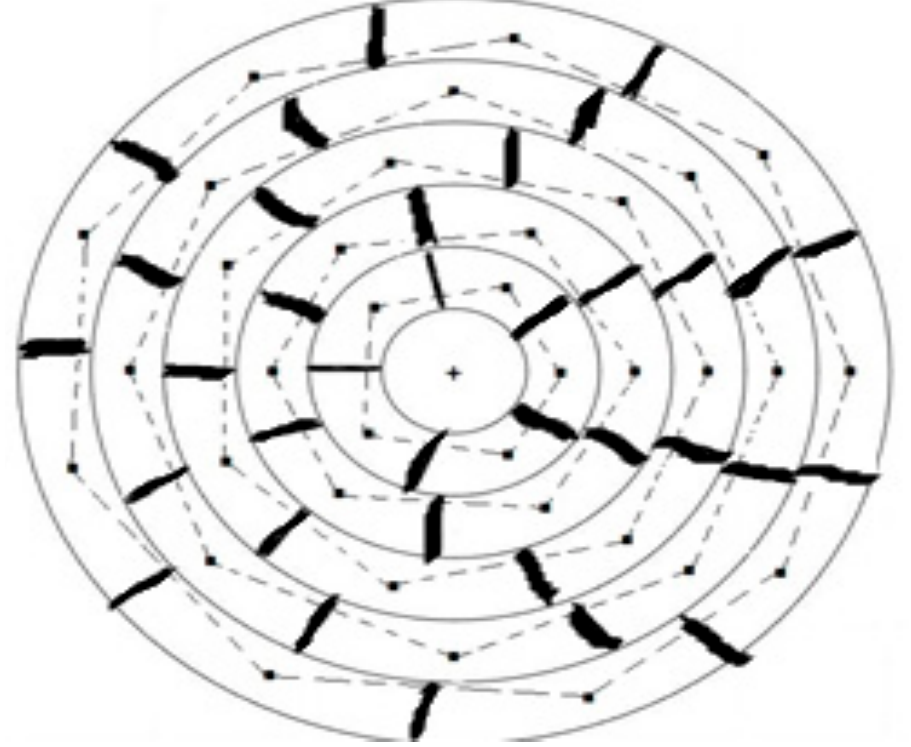
Figure 1. Localization of all vaccination centres belonging to the concerned territorial area.